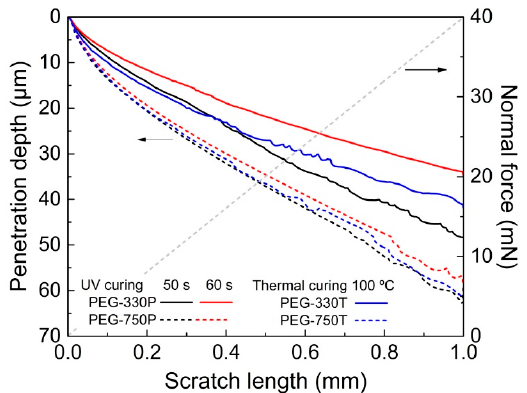
Figure 8. Penetration depths for several PEG-330 and PEG-750 hydrogels films produced via a UV or